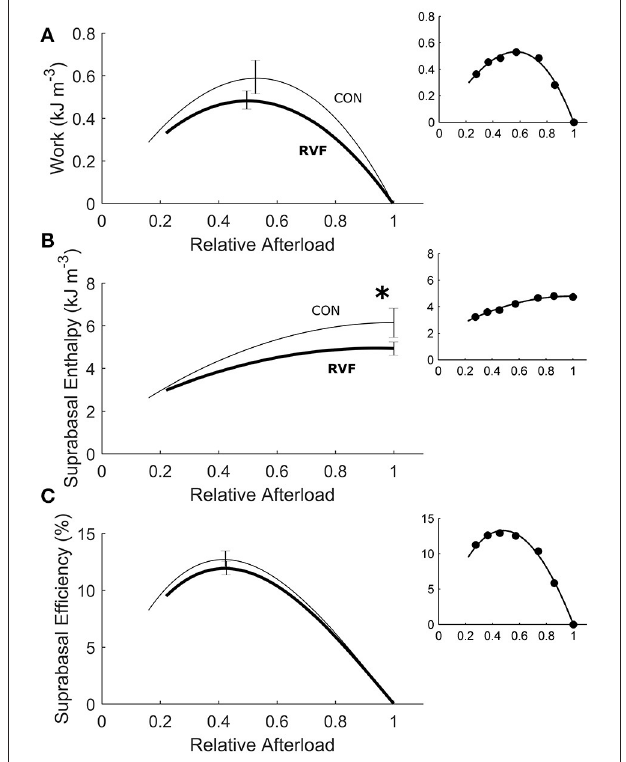
FIGURE 8 | Energetics of in vitro left-ventricular trabeculae performing work-loop contractions. As functions of relative afterload, work output (A) (equivalent to the area of the loop in Figure 6C ) was not statistically different between groups ( P = 0.2090) but change of enthalpy (B) (the sum of work and suprabasal heat output) was lower in the RVF trabeculae (thick lines) than in the Control trabeculae (thin lines), as indicated by the asterisk. Suprabasal efficiency was not different between groups (C) . All insets show data set obtained from a representative